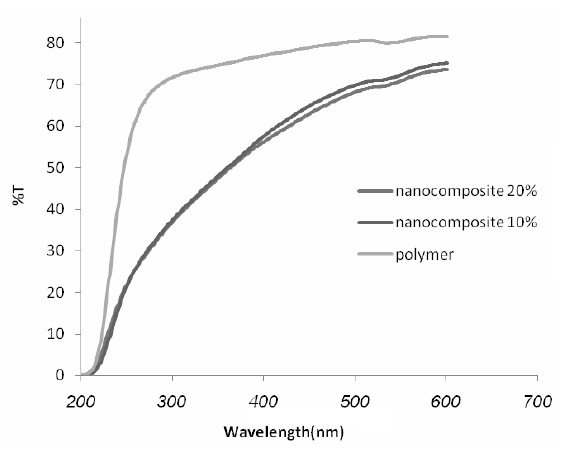
Figure 7. Uv-vis spectra of PAI4, PAI-nanocomposite films 4a and 4b.